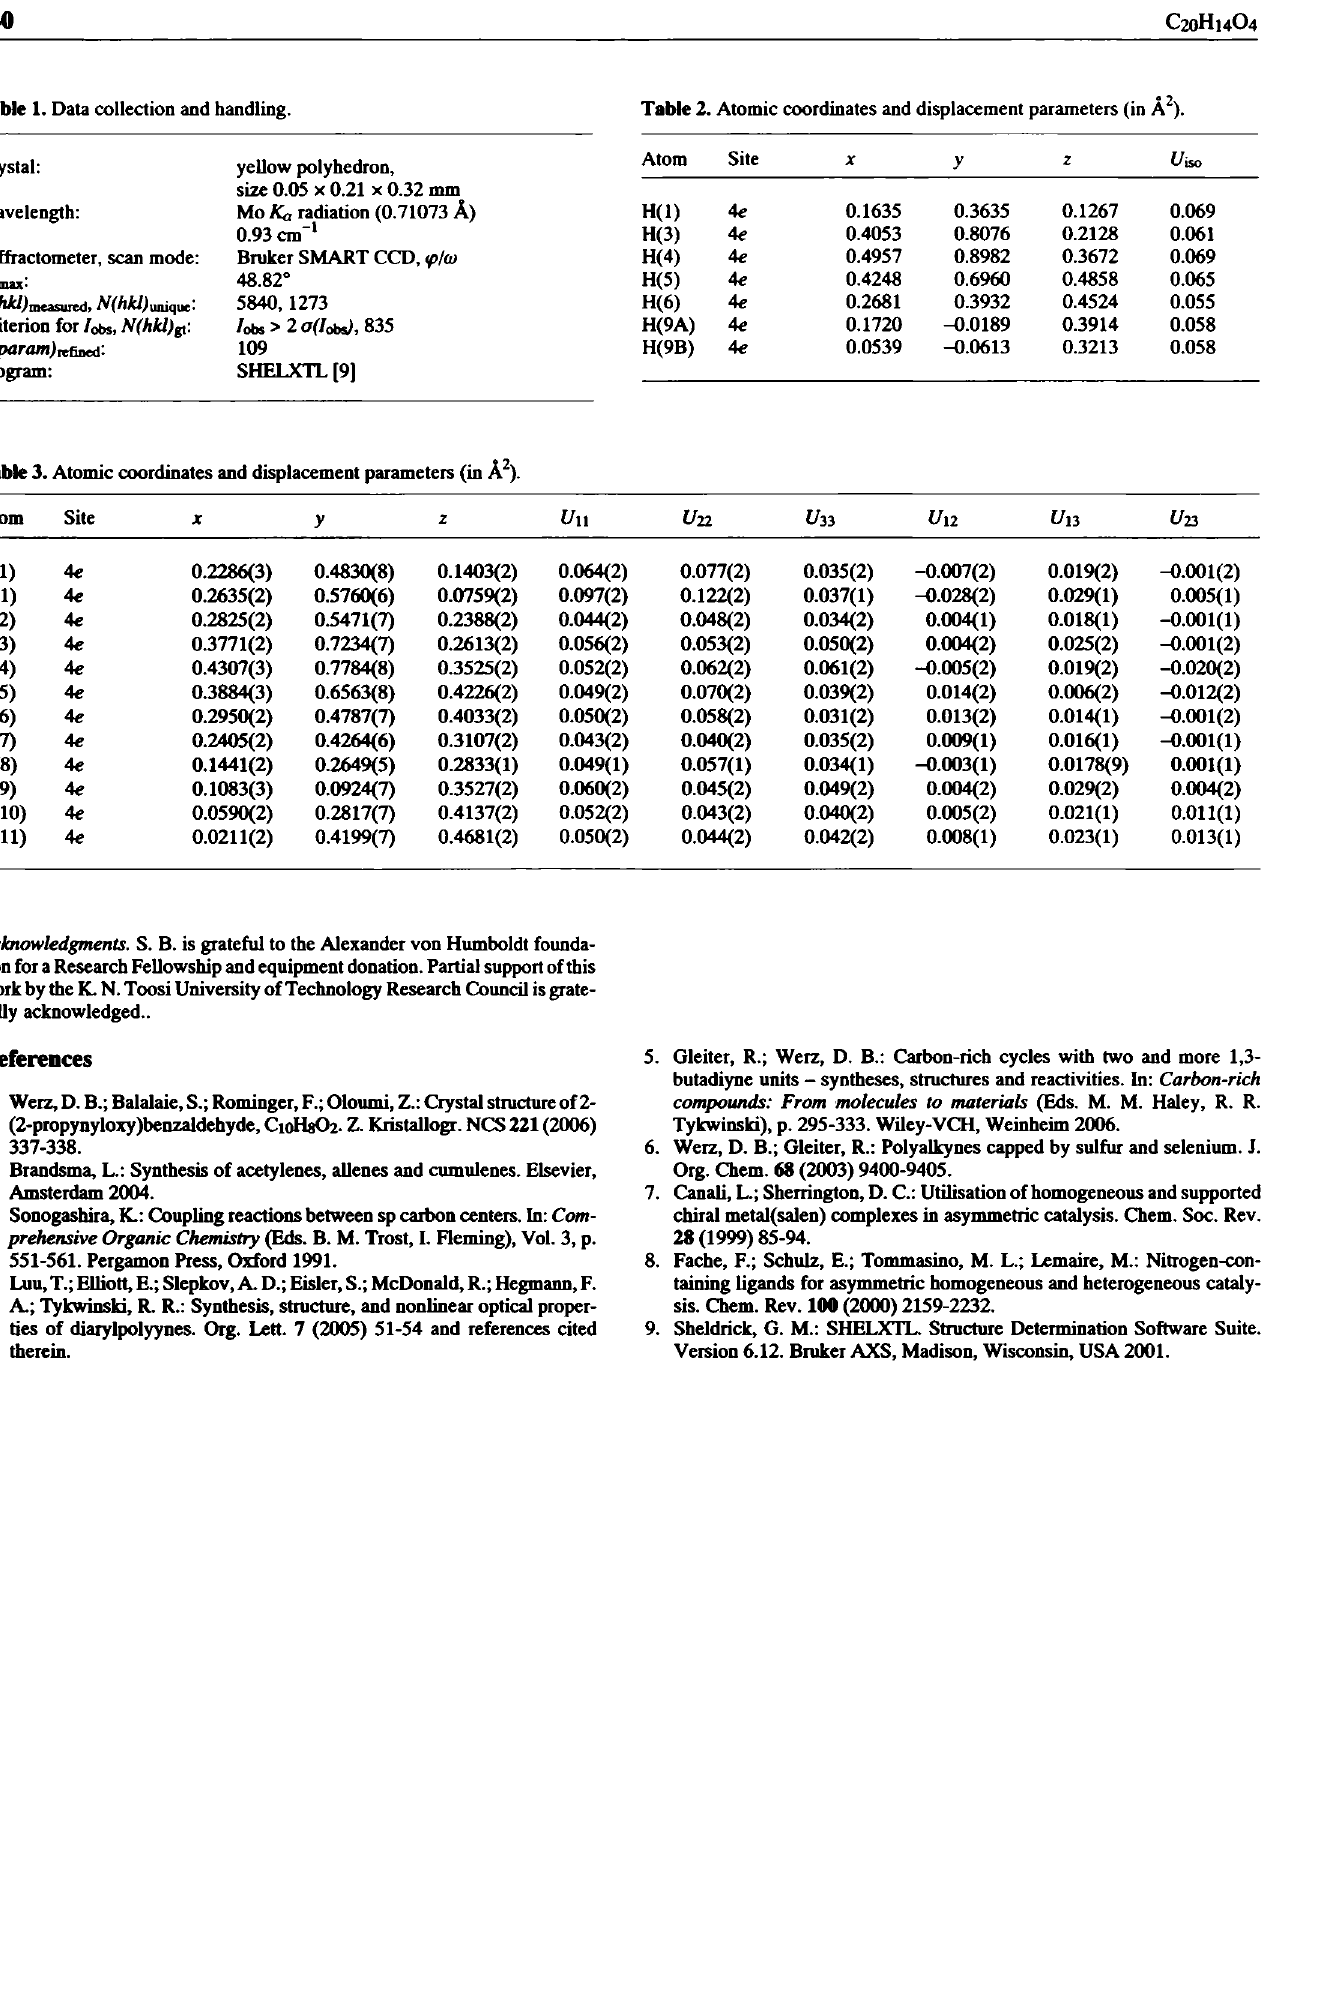
Table 1. Data collection and handling. Table 2. Atomic coordinates and displacement parameters (in Ä 2 ).